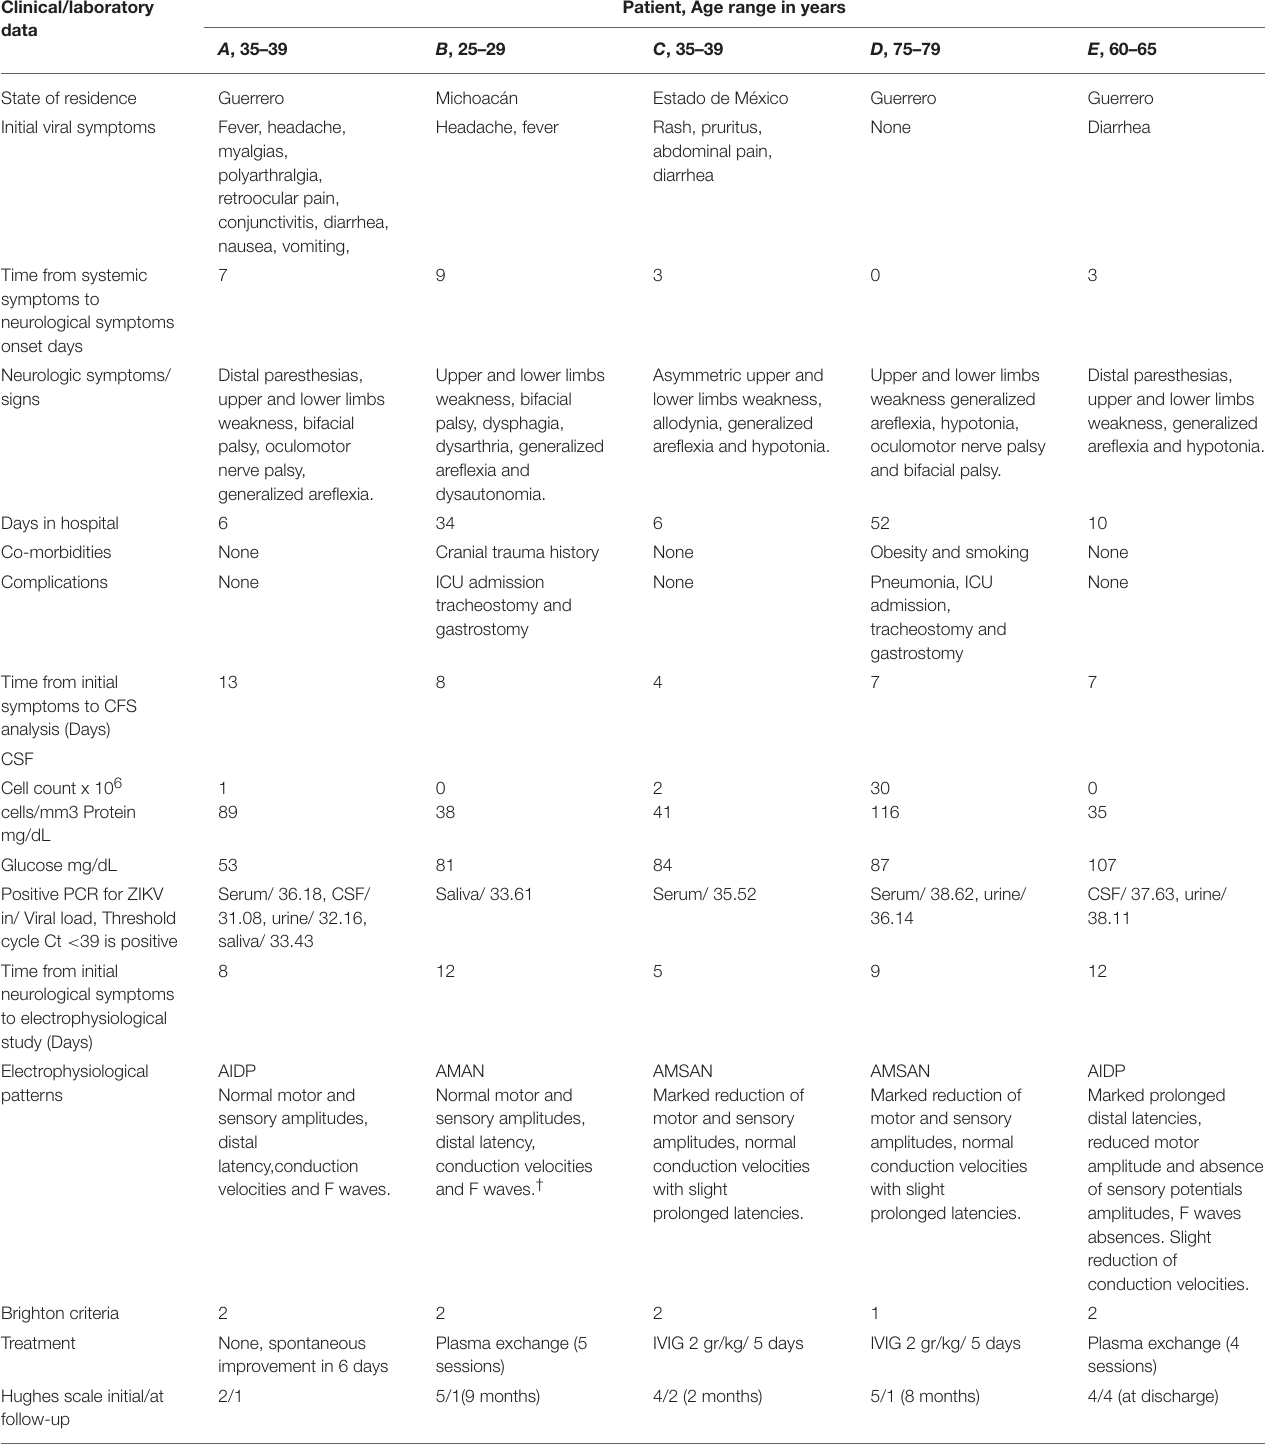
TABLE 1 | Features of patients with Guillain Barré syndrome from México, July-November 2016. Clinical/laboratory